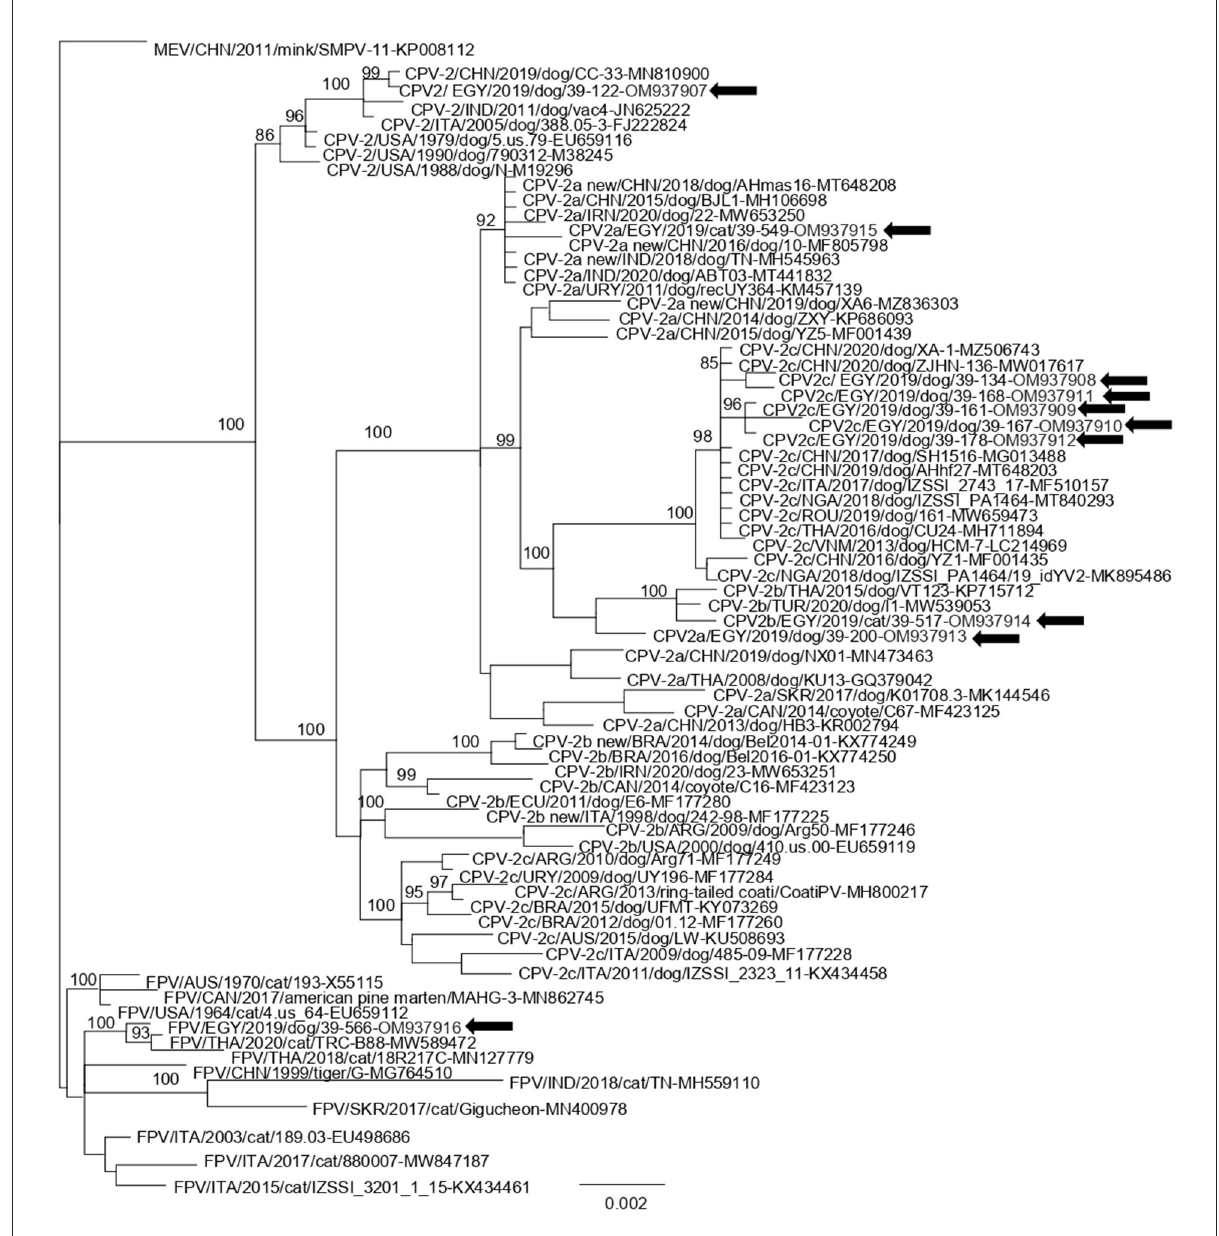
FIGURE2 Bayesian open reading frame (ORF)2-based phylogenetic tree of Carnivore protoparvovirus 1. The tree was elaborated using a 1,755 nt long alignment of the ORF2 sequence of the Egyptian canine parvovirus (CPV) and feline panleukopenia virus (FPV) strains identified in this study and the cognate sequences of Carnivore protoparvovirus 1 strains retrieved from the GenBank database. The posterior output of the tree was derived using a general time-reversible model, a proportion of invariable sites, a gamma distribution of rate variation across sites, and a subsampling frequency of 1,000. Posterior probability values > 95% are indicated at the tree nodes. The black arrows indicate the Egyptian strains generated in this study. The scale bar indicates the number of nt substitutions per site.